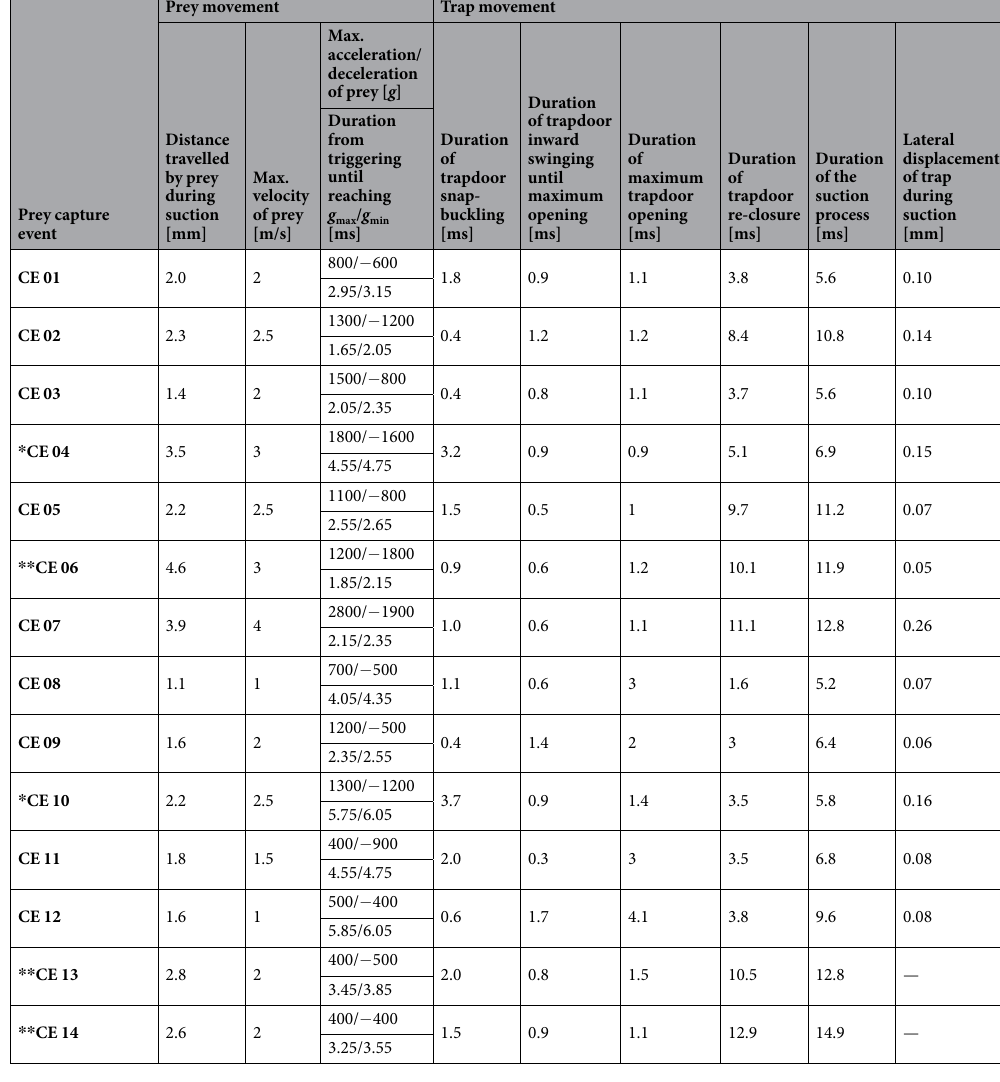
Table 2. Prey movement, durations of trap movement phases, and lateral displacements of traps. CEs marked by a single asterisk ( * CEs 04, 10) or with a double asterisk ( ** CEs 06, 13, 14) occurred in the same traps, respectively. See Fig. 1 for schematic representation of the trapdoor movement